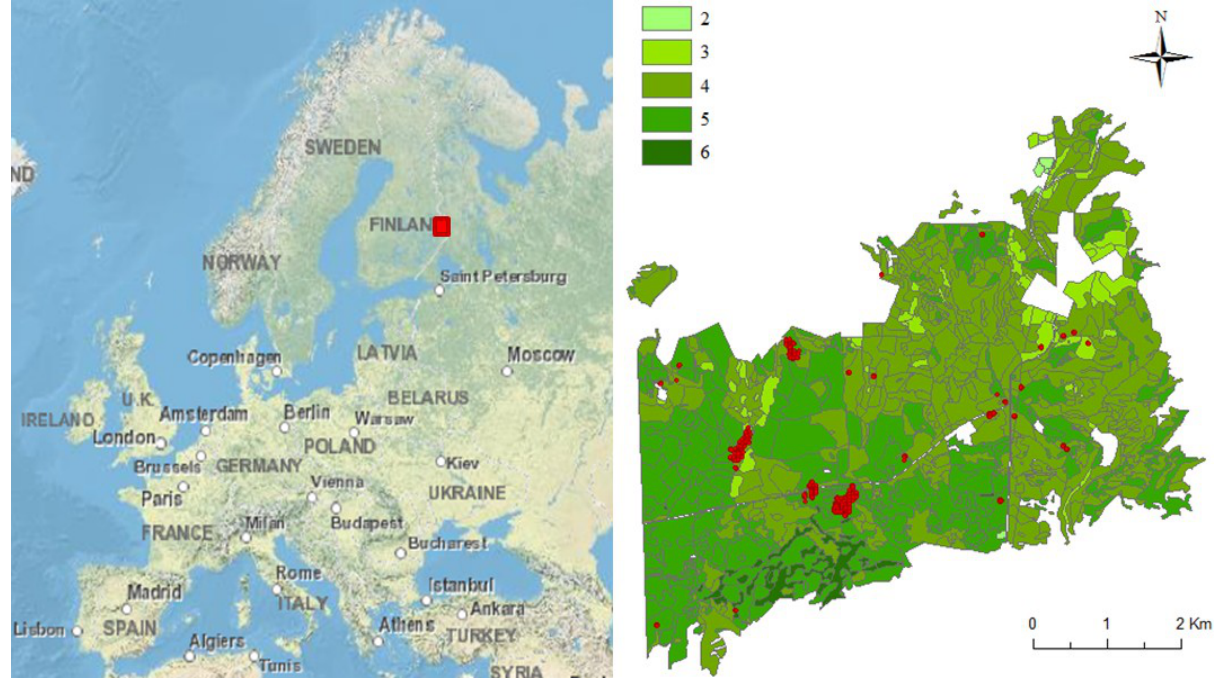
Figure 1. Location of the study area (left, ESRI © ) and map with tree locations (red) and forest compartments. (Green colors indicates different site types, 2 = grove-like heath, 3 = fresh heath, 4 = dryish heath, 5 = dry heath and 6 = barren